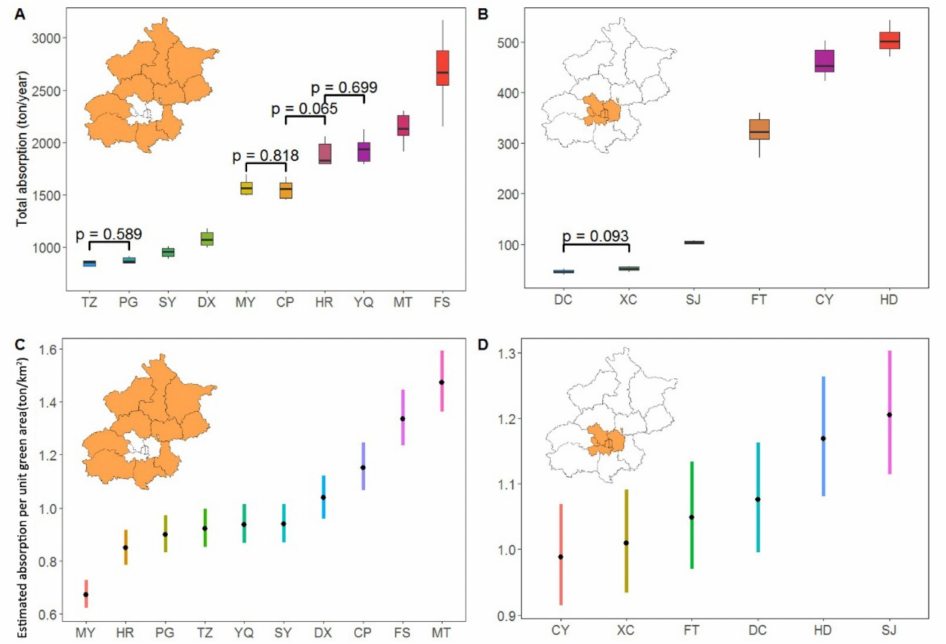
Figure 3. Annual total NO 2 absorption and absorption of NO 2 per unit of green area in 16 districts from 2014 to 2014. ( A ): annual total absorption in 10 suburban districts. ( B ): annual total absorption in six urban districts. ( C ): absorption of NO 2 per green area in 10 suburban districts and range. ( D ): absorption of NO 2 per unit of green area in six suburban districts and range. We tested the differences of mean total absorption in subgraph ( A ) and subgraph ( B ). For simplicity of the figure, only comparisons that are not significantly different are